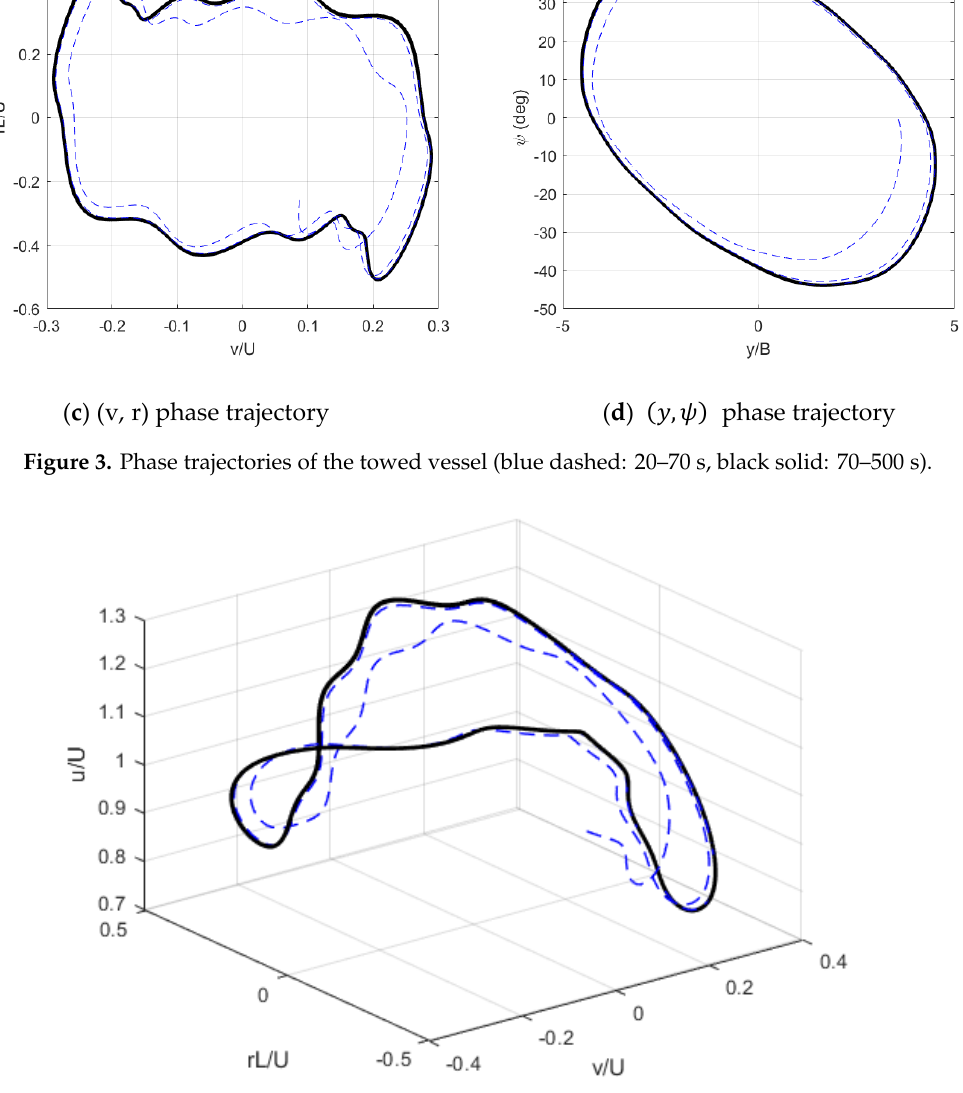
Figure 4. Phase trajectories of the towed vessel in the three-dimensional phase space (blue dashed: 20–70 s, black solid: 70–500 s).